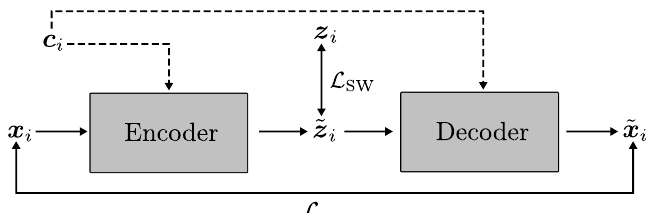
Figure 3: The cSWAE architecture for simulating hadronization. Inputs x condition c , which parametrizes the string energy. The decoder takes ˜ z i and generates the predicted hadron kinematics ˜ x distance loss function, , constrains the latent-space vectors ˜ z L SW ∼ I ( ˜ z ) . The reconstruction loss function, bution ˜ z , c i i i between x and ˜ x i i